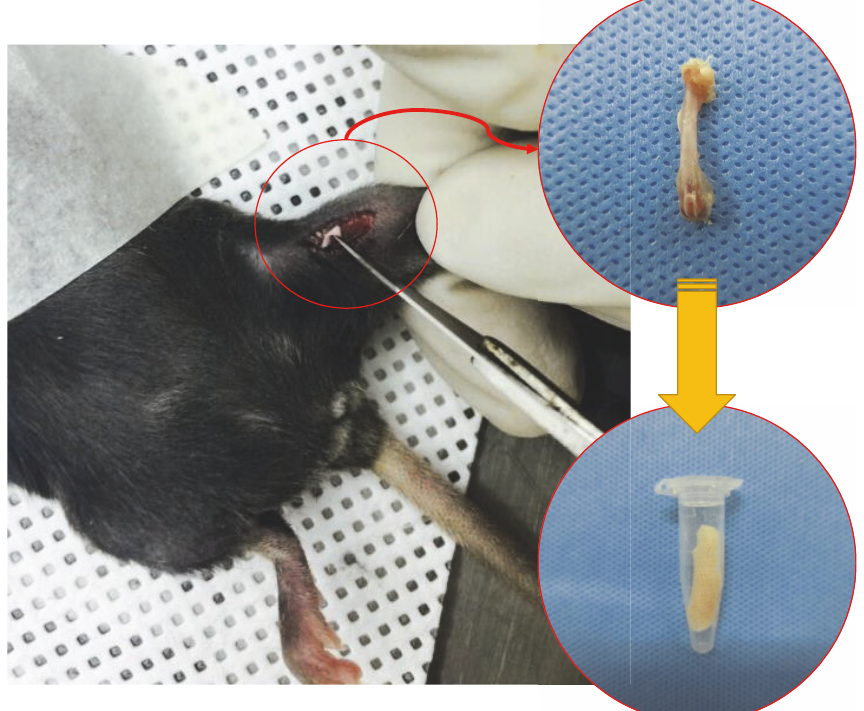
Figure 1: The right femurs were extracted for the femoral head compression test.